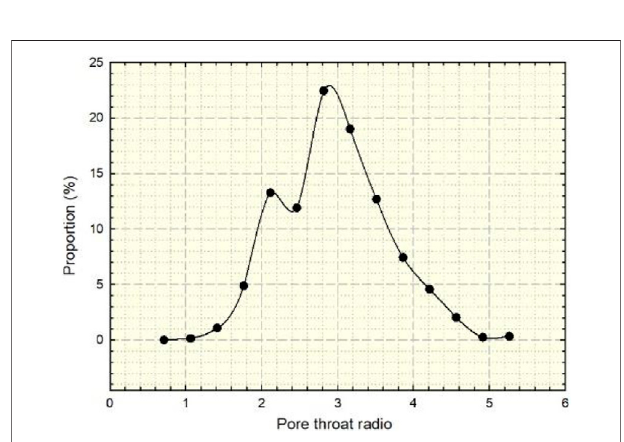
FIGURE 4 | Statistical graph of the real core pore – throat